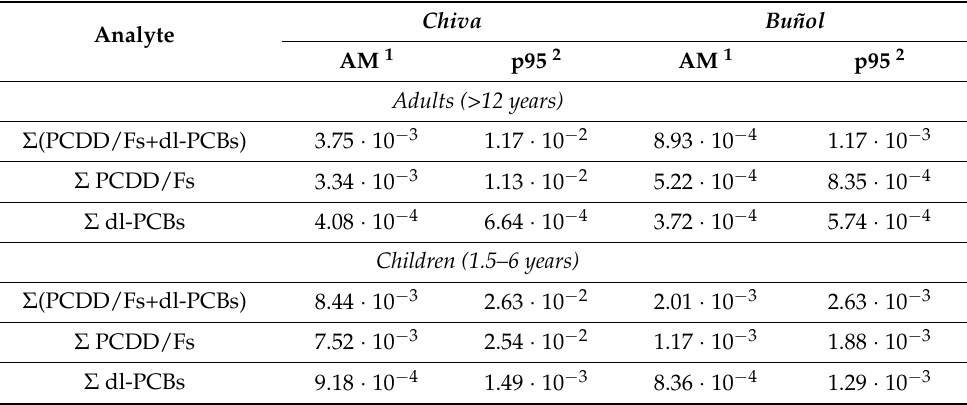
Table 4. Daily inhalation exposure in adults (>12 years) and children (1.5–6 years) at each station in pg WHO TEQ kg − 1 b.w. d − 1